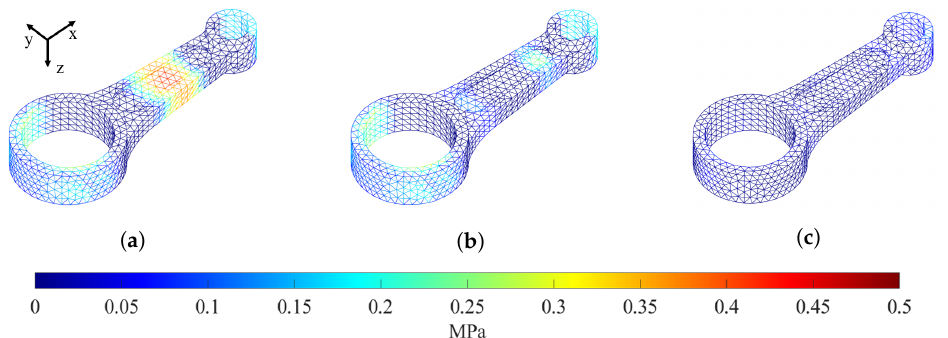
Figure 17. The error contour of the von Mises stress of the different error tolerance e i = 10%, 1%, and 0.1% for t = 0.4495 s. ( a ) e i = 10%; ( b ) e i = 1%; ( c ) e i =